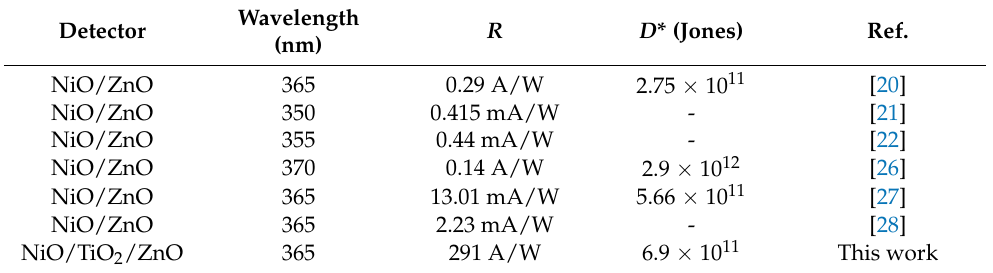
Table 1. Performance parameters of UV detector based on